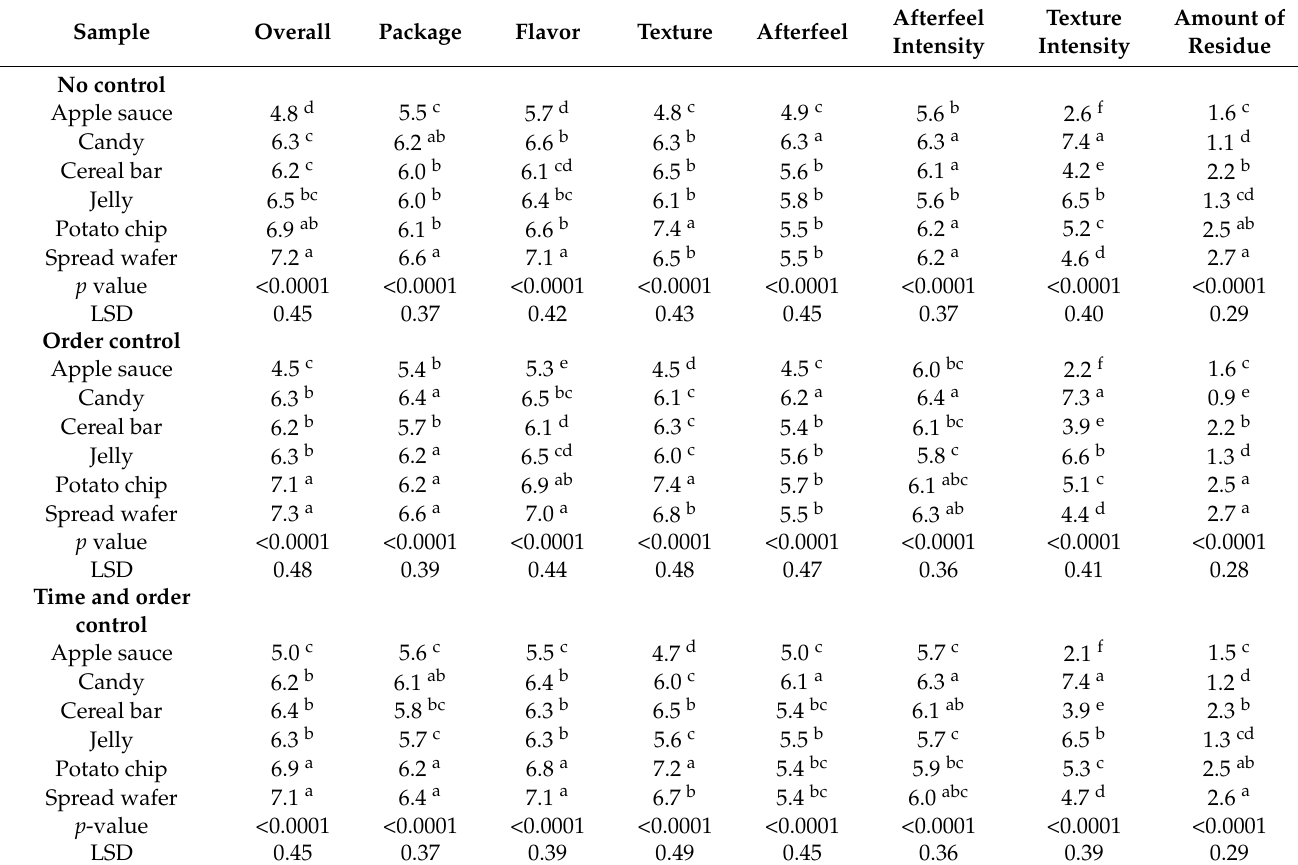
Table 6. Consumer’s liking and perceived intensity of ‘No control’, ‘Order control’, and ‘Time and order control’ groups 1, 2, 3 . Sample Overall Package Flavor Texture Afterfeel